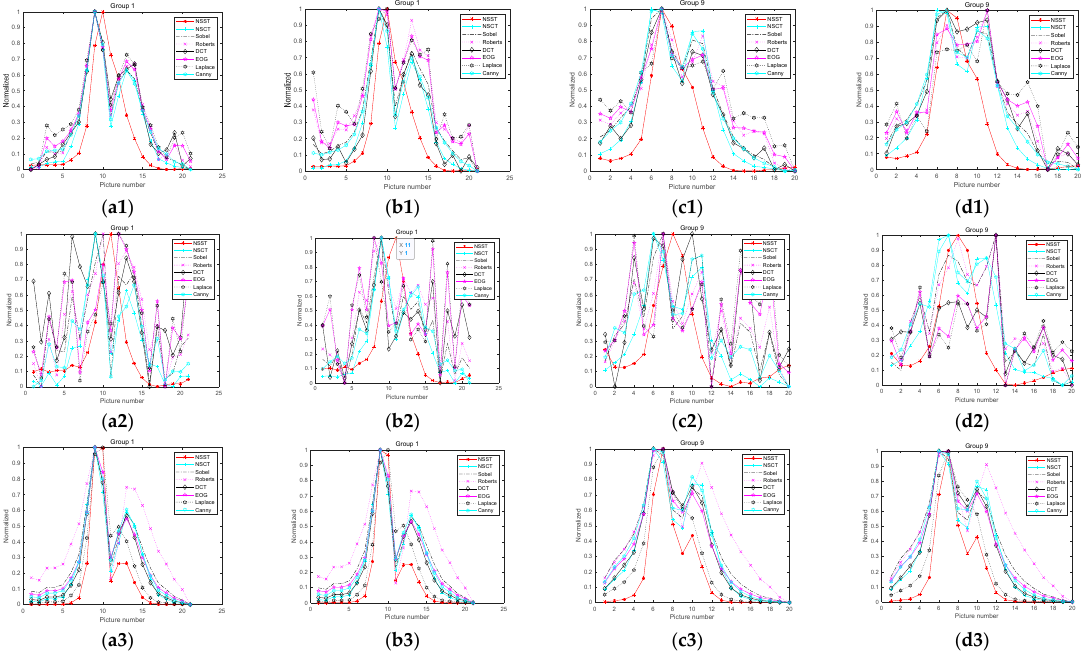
Figure 8. Curves after noises and filters are added: ( a1 ) Gaussian noise and bilateral filter of Group 1; ( b1 ) Gaussian noise and guided filter of Group 1; ( c1 ) Gaussian noise and bilateral filter of Group 9; ( d1 ) Gaussian noise and guided filter of Group 9; ( a2 ) salt-and-pepper noise and bilateral filter of Group 1; ( b2 ) salt-and-pepper noise and guided filter of Group 1; ( c2 ) salt-and-pepper noise and bilateral filter of Group 9; ( d2 ) salt-and-pepper noise and guided filter of Group 9; ( a3 ) Poisson noise and bilateral filter of Group 1; ( b3 ) Poisson noise and guided filter of Group 1; ( c3 ) Poisson noise and bilateral filter of Group 9; ( d3 ) Poisson noise and guided filter of Group 9.